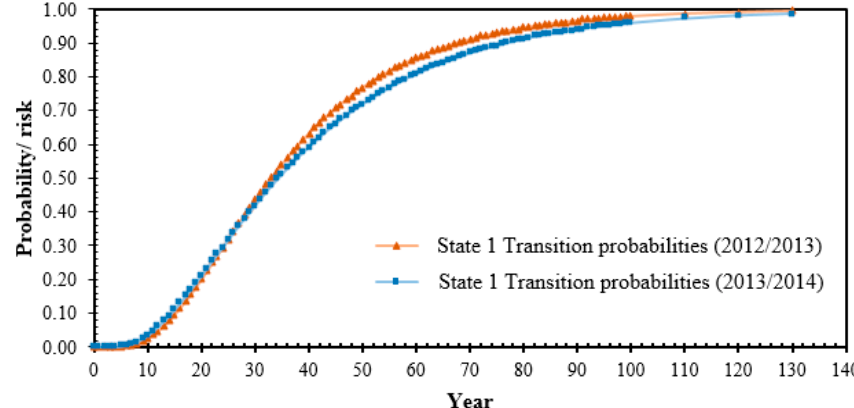
Figure 8. Predicted state probabilities for State 1 in the year 2015 based on transformer transition states for the year 2013/2014 and 2012/2013.